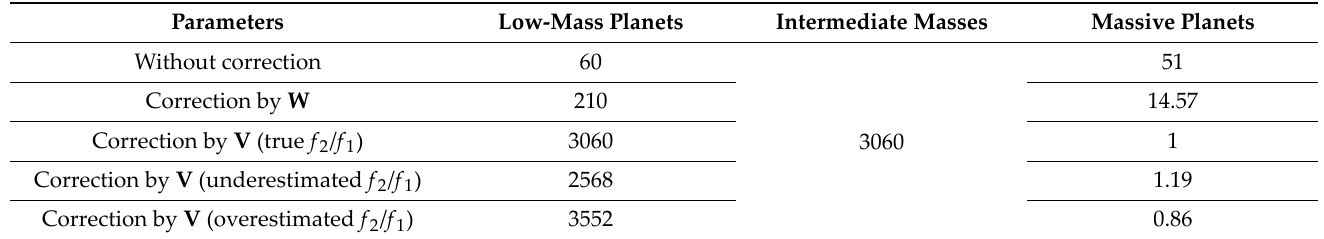
Table A1. De‑biased number of light planets depending on applied method ( W or V matrices).